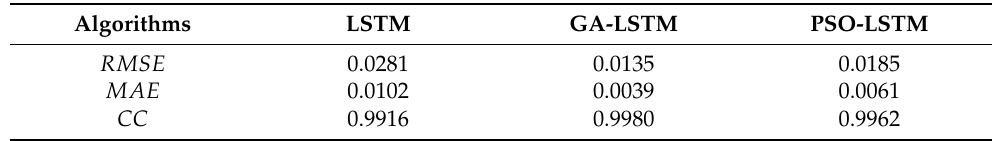
Table 1. Performance criteria of the CO 2